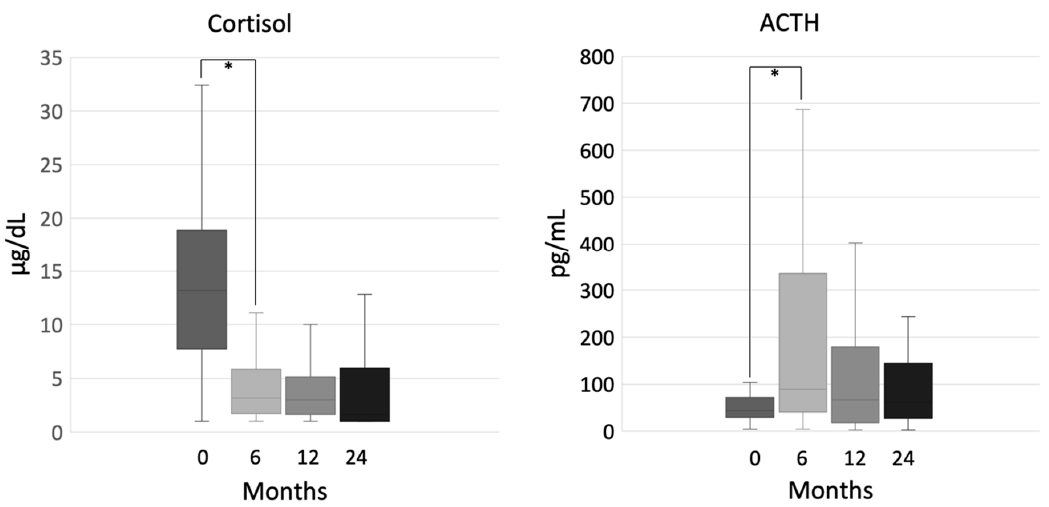
Figure 1. Cortisol and adrenocorticotropic hormone (ACTH) during mitotane therapy; * indicates statistical significance.